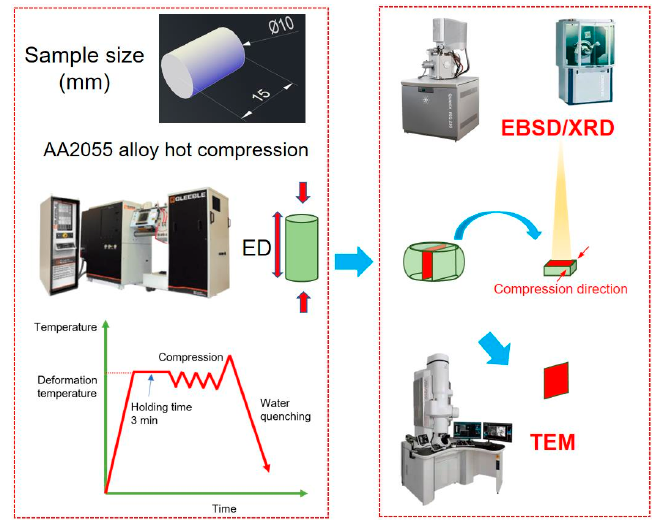
Figure 1. The diagrammatic sketch of the experimental procedure. Adapted from ref.